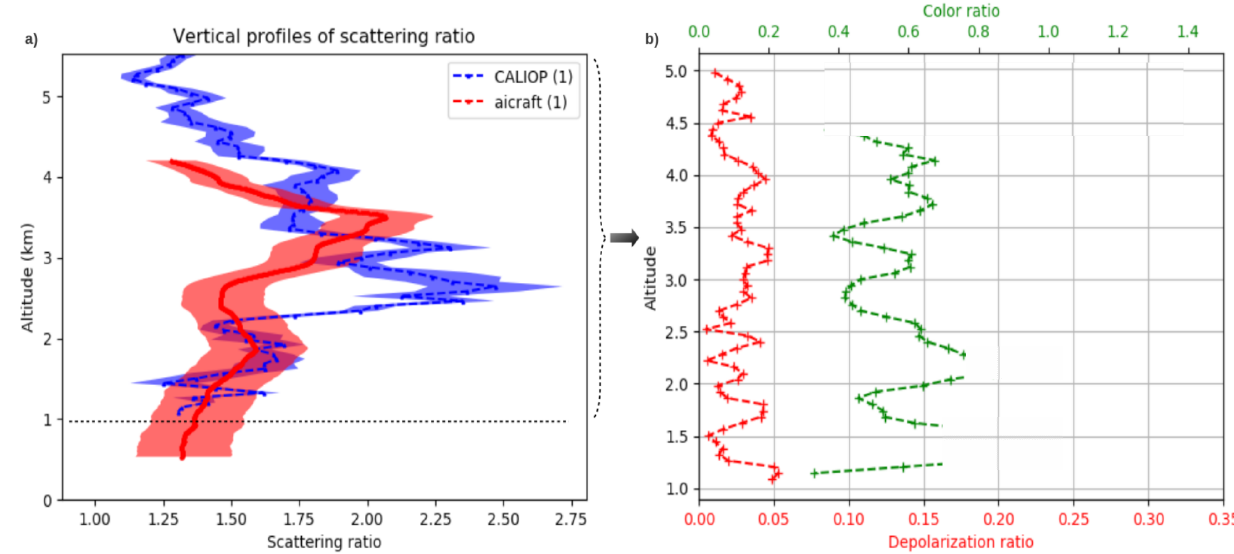
Figure 25. ( a ) Vertical profiles of 532 nm backscatter ratio for the aircraft lidar in red box of Figure 22a (red line) and for CALIOP on 18 July 2013 at 18 UT and 57 ◦ N (blue line). ( b ) Vertical profiles of the particle color ratio (green) and particle linear depolarization ratio (red) measured by